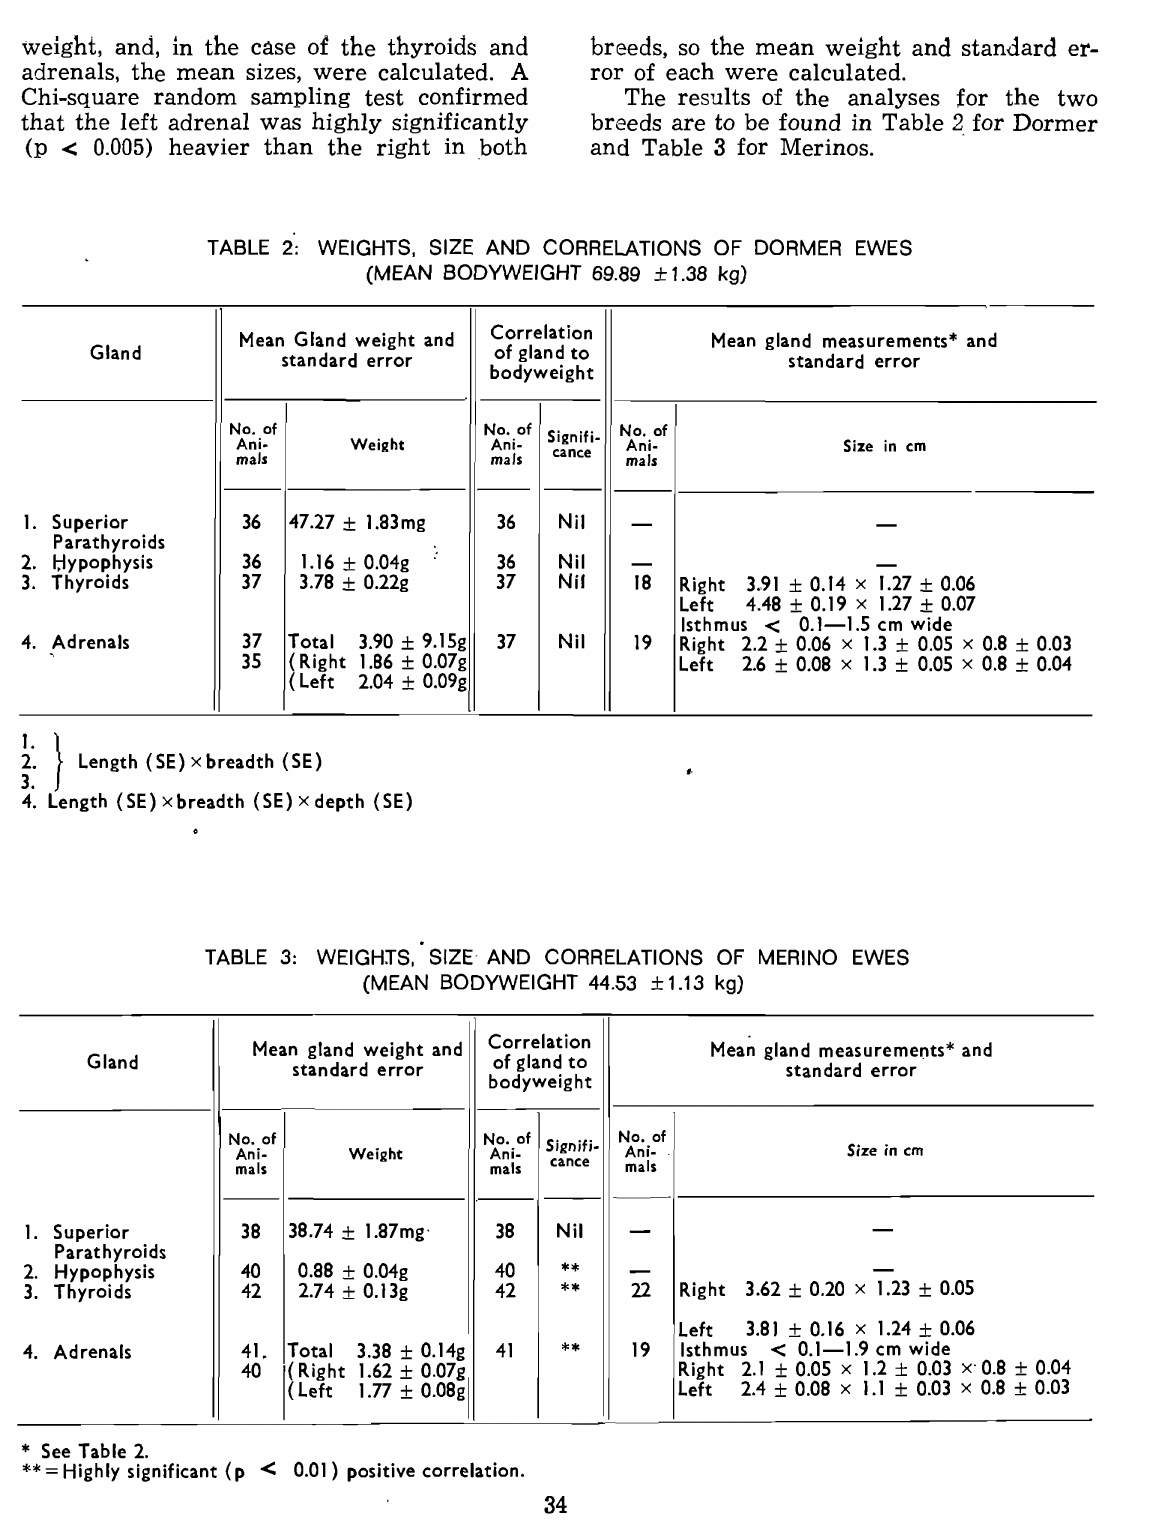
TABLE 3: WEIGHJS, SIZE AND CORRELATIONS OF MERINO EWES (MEAN BODYWEIGHT 44.53 ± 1.13